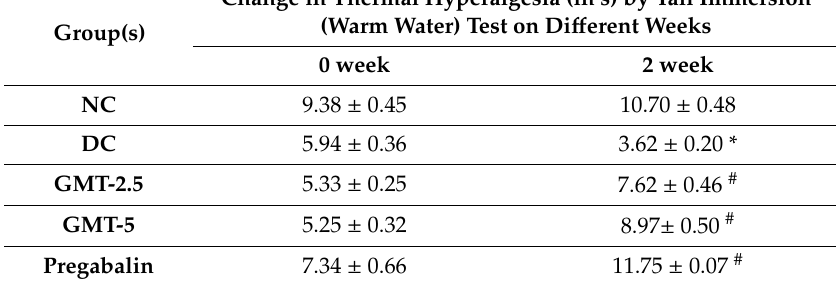
Table 3. E ff ect of chloroform extract of goat milk treated A. napellus on thermal hyperalgesia assessed by tail immersion (warm water) test.